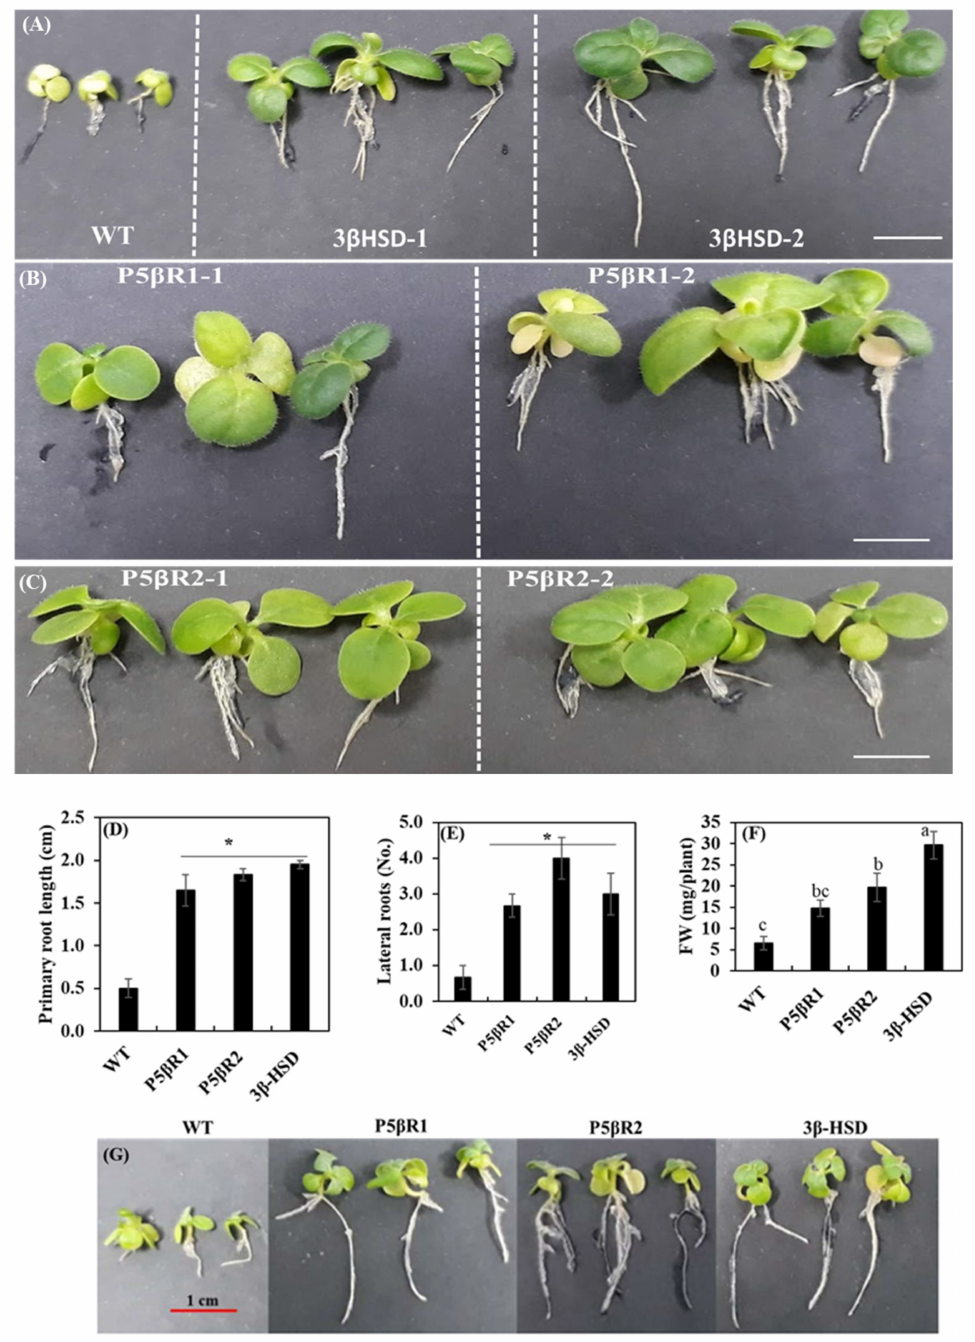
Figure 5. Phenotype of WT and the independently generated transplastomic lines of the 3 β -HSD , P5 β R1 and P5 β R2 genes (3 β HSD-1, 3 β HSD-2, P5 β R1-1, P5 β R1-2, P5 β R2-1 and P5 β R2-2) under salt and mannitol stresses. Impact of salt stress on the phenotype of WT and transplastomic lines when exposed to 300 mM NaCl on MS media. Photographs were taken after 30 days of culture. Independent transplastomic lines of 3 β -HSD ( A ); P5 β R1 ( B ); and P5 β R2 ( C ) exhibited bigger green leaves and longer roots than WT. The osmotic stress was applied to root excised seven-day-old seedlings at 400 mM mannitol concentration for the period of 25 days on MS media. After 25 days, the phenotypic data of WT and transplastomic seedlings for root length, lateral root number and fresh weight of shoots was measured. WT and transplastomic seedlings ( n = 15). ( D ) The significant difference for root length among WT and transplastomic seedlings is indicated by an asterisk. ( E )